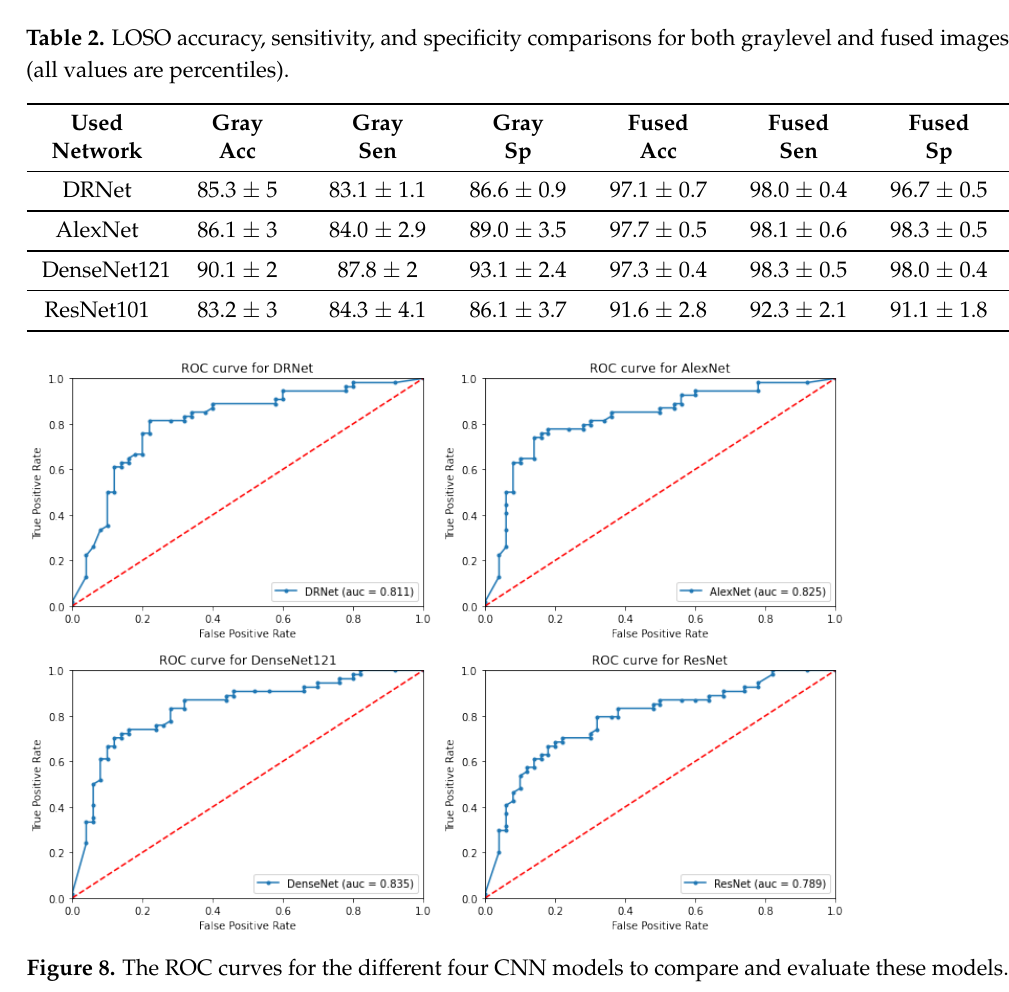
Figure 8. The ROC curves for the different four CNN models to compare and evaluate these